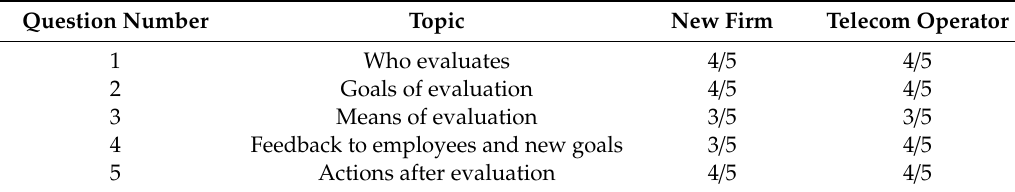
Table 4. Evaluation of existing employees and employer